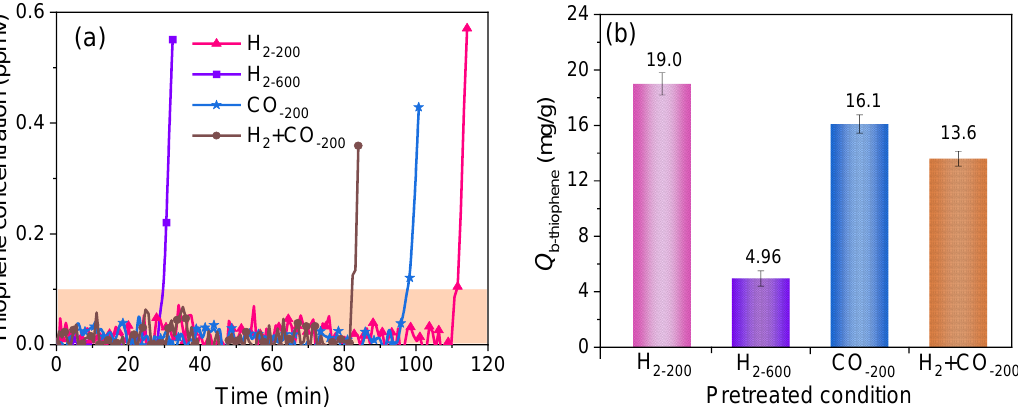
Figure 12. Thiophene breakthrough adsorption curves ( a ) and Q b-thiophene ( b ) of NaCeY sorbent pretreated at different conditions. (Desulfurization temperature is 200 °C; desulfurization atmosphere is N 2 .).